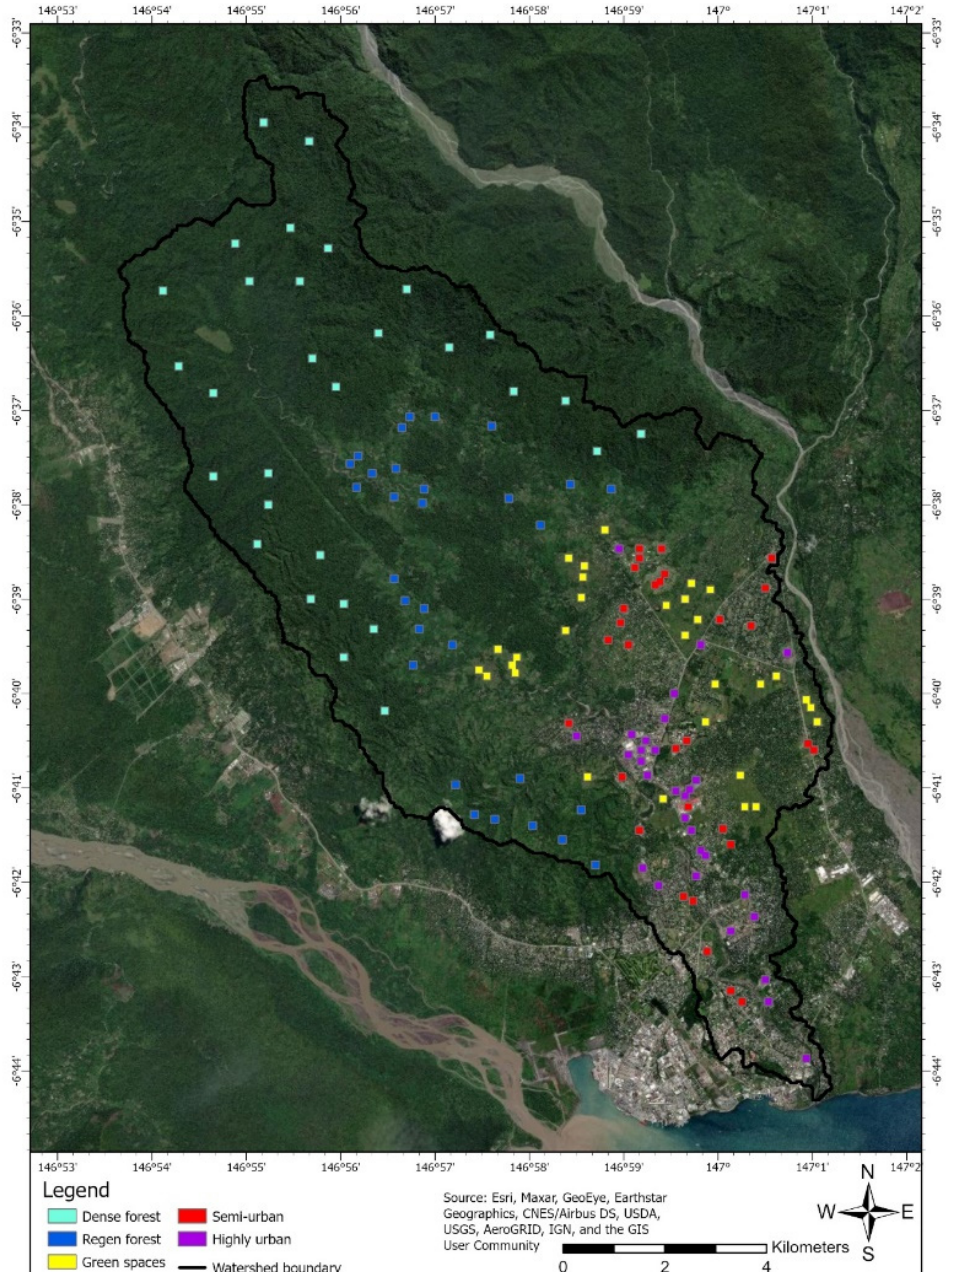
Figure 5. Signature polygons used for categorization of the Bumbu Watershed. In total, 30 sample points for each class were identified to implement the MLE clustering technique.